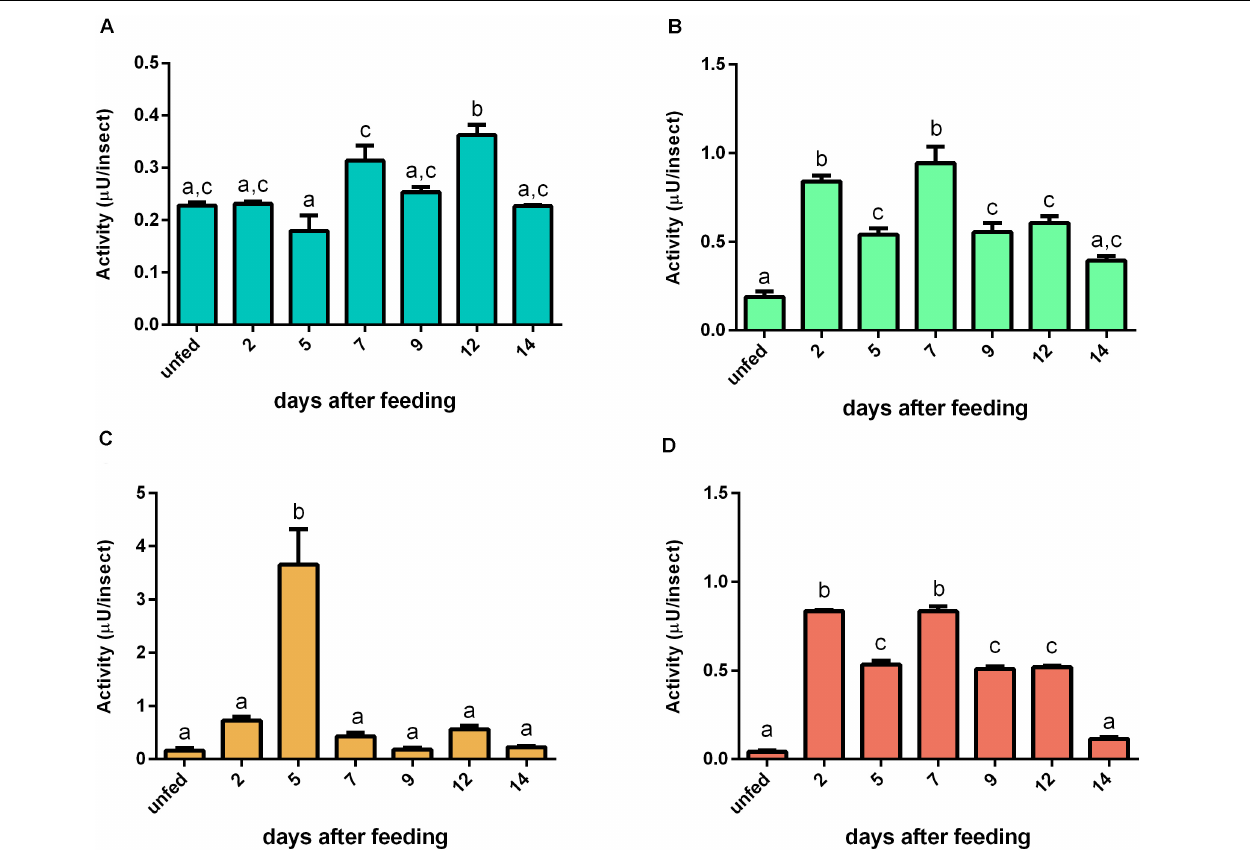
FIGURE 7 | The proteolytic activity ( µ U per insect) on casein in the different digestive compartment tissues and luminal contents of Rhodnius prolixus male adults, unfed and at 2, 5, 7, 9, 12, and 14 daf on defibrinated rabbit blood, assayed in 0.2 M citrate-phosphate buffer, pH 5.5. (A) Anterior midgut tissues. (B) Posterior midgut tissues. (C) Anterior midgut contents. (D) Posterior midgut contents. Figures are means ± SEM from three different homogenate samples obtained from pools of two insects each. In a dataset, groups with the same superscript letter are not significantly different ( p > 0.05). Statistical analysis consisted of ordinary one-way ANOVA with Tukey’s multiple-comparisons test. Consider different scalings of